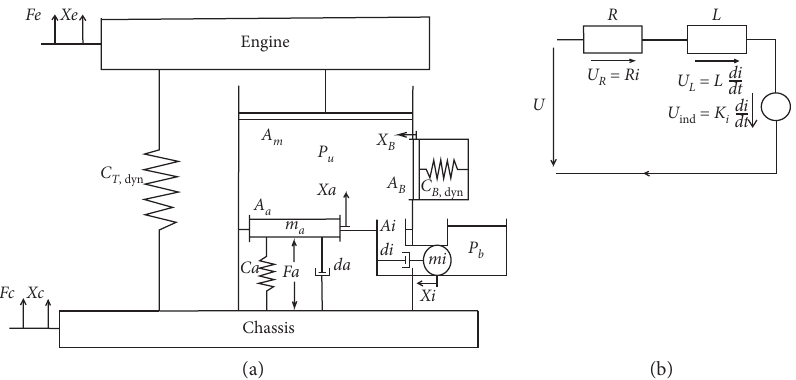
Figure 5: Lumped parameter model of an AEM with a voice coil [85]: (a) lumped parameter model; (b) circuit of voice coil